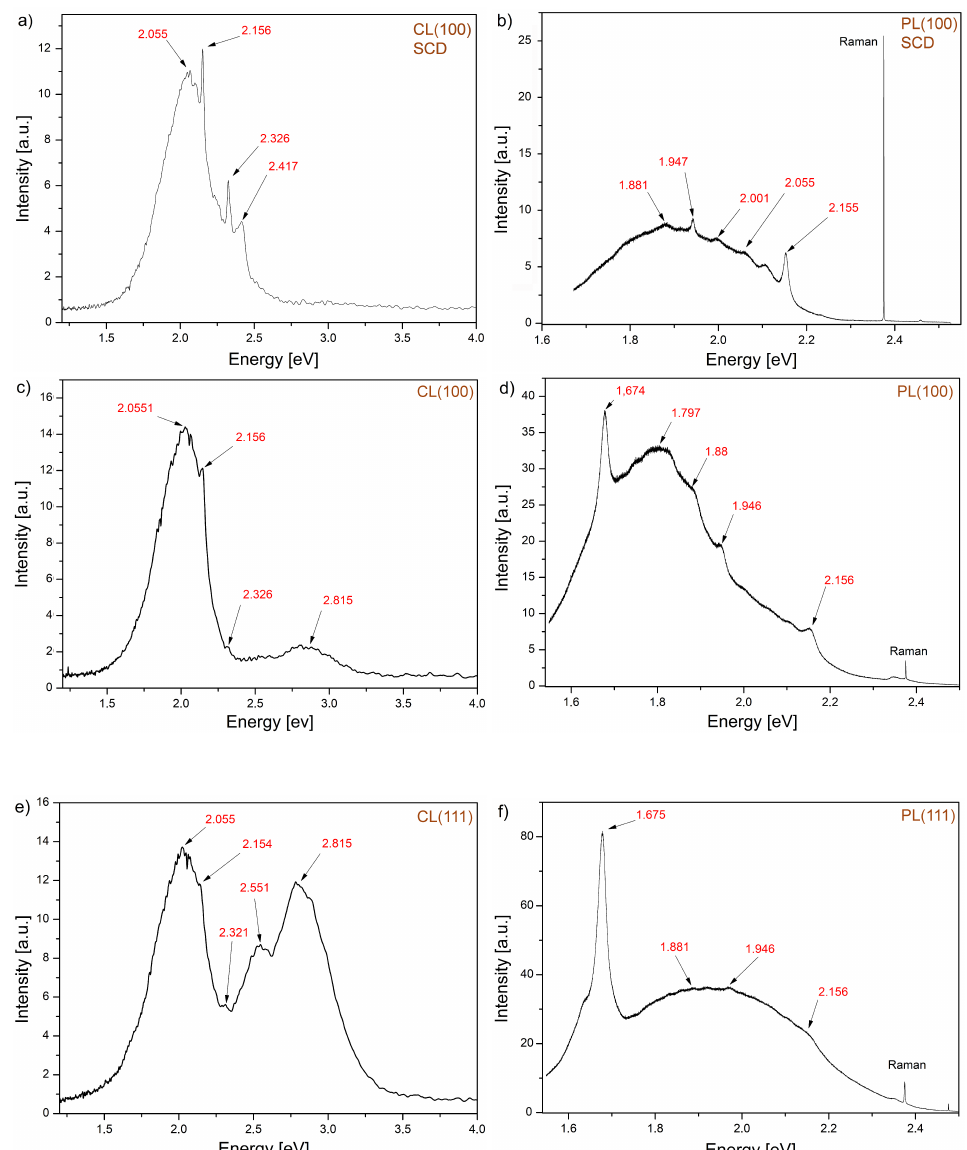
Figure 2. The recorded CL and photoluminescence (PL) spectra respectively for: ( a , b ) Element Six monocrystal, the spectra were taken from the plane (100); ( c , d ) hot filament chemical vapor deposition (HF CVD) microcrystal, the spectra were taken from the (100) plane; and ( e , f ) the spectra were taken from the (111)